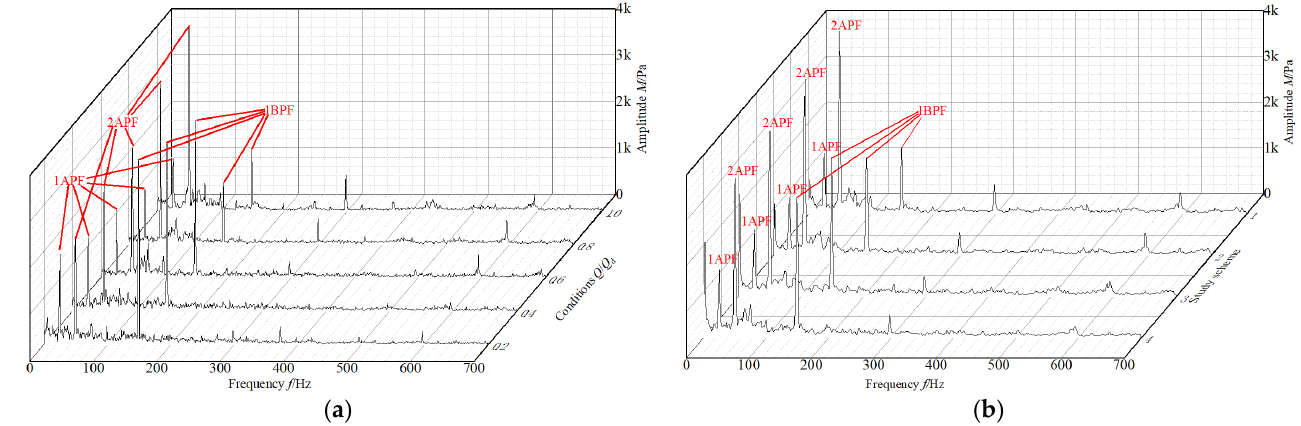
Figure 9. Frequency distribution at P2 under each ( a ) Steady conditions and ( b ) Transient conditions.